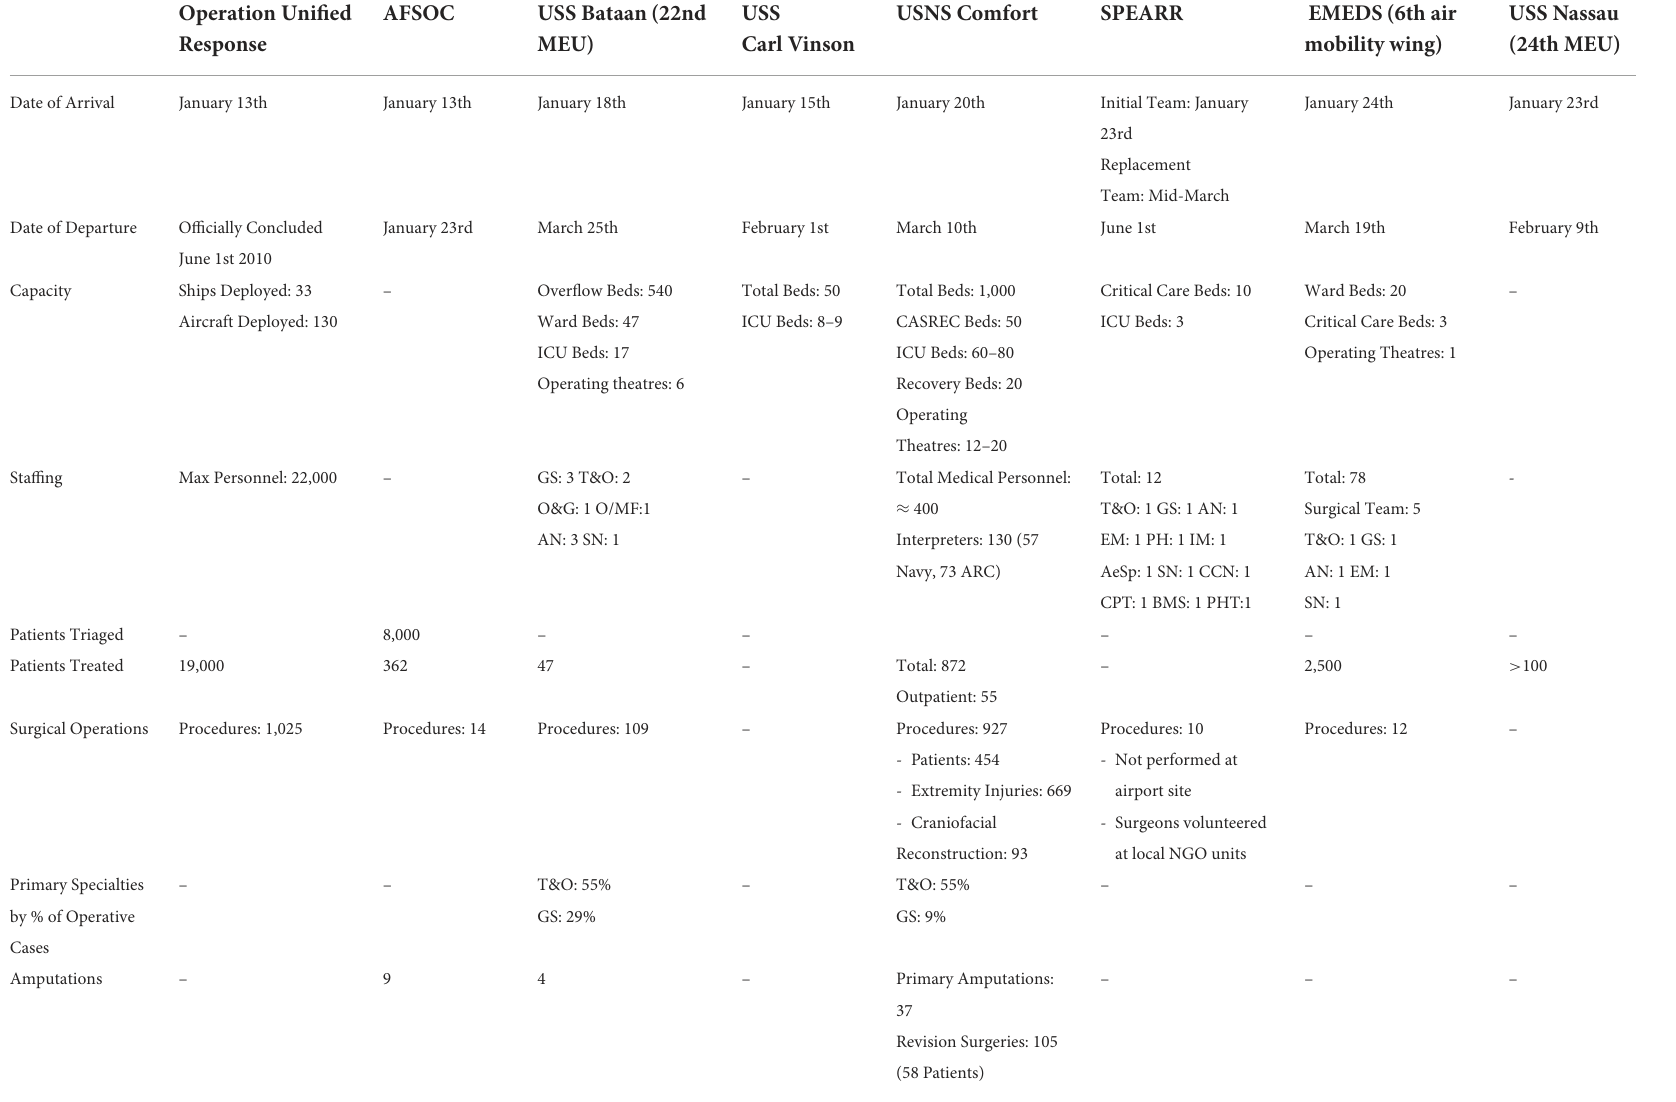
TABLE 6 Summary of healthcare operations: United States